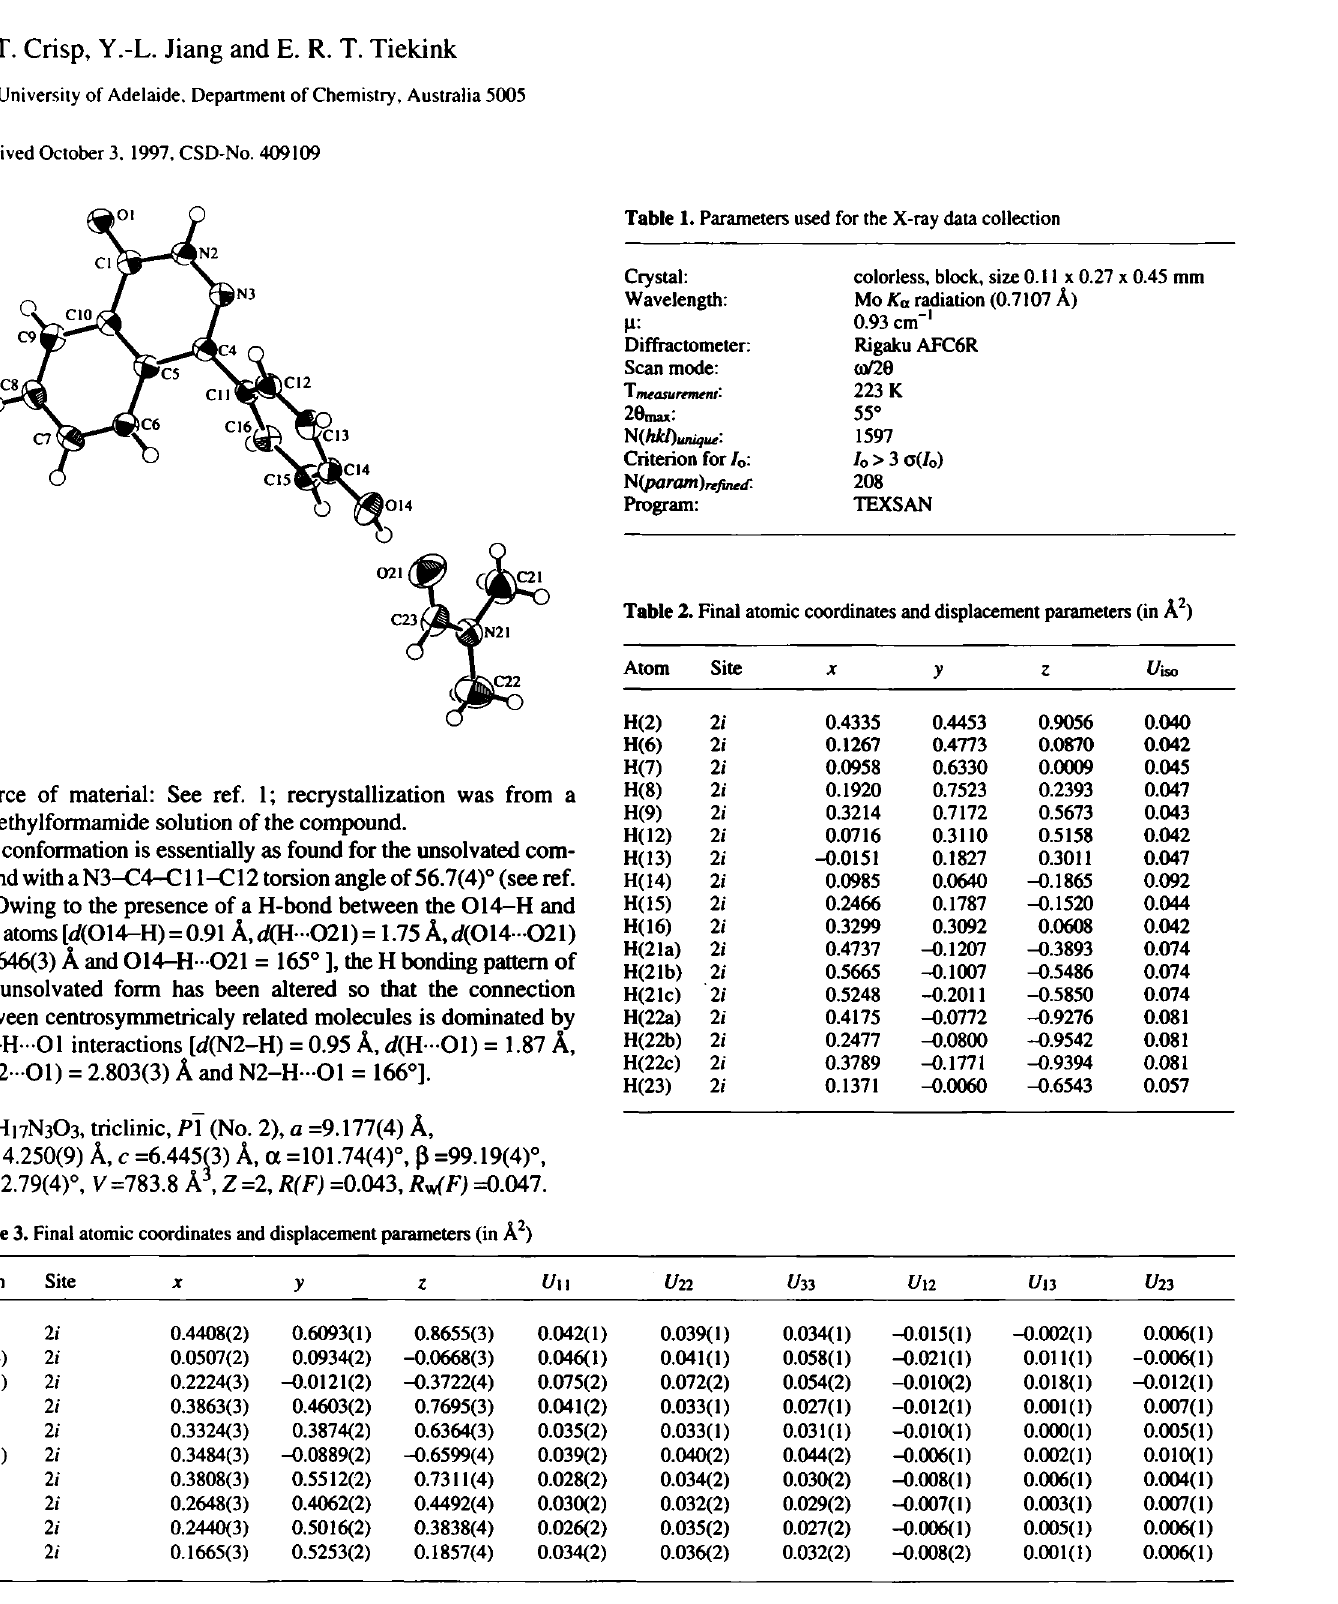
Table 2. Final atomic coordinates and displacement parameters (in